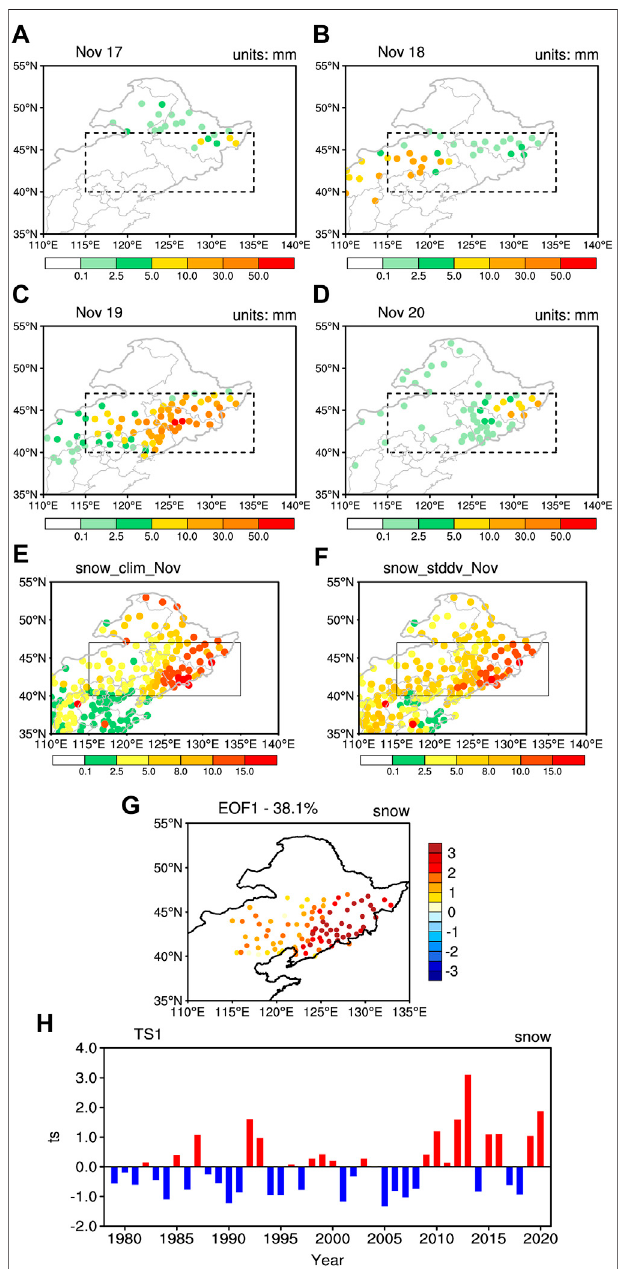
FIGURE 1 | Observed daily snowfall (unit: mm) over Northeast China on (A) 17November, (B) 18November, (C) 19 November, and (D) 20November 2020. (E) the climatology of the November-mean snowfall (unit: mm). (F) the standard deviations of the November-mean snowfall (unit: mm). Black rectangles indicate the averaging area for the snowfall index. (G) the spatial pattern of the leading EOF mode of November snowfall in 40 ° N – 47 ° N, east of 115 ° E in China; (H) corresponding time series of the leading EOF mode.